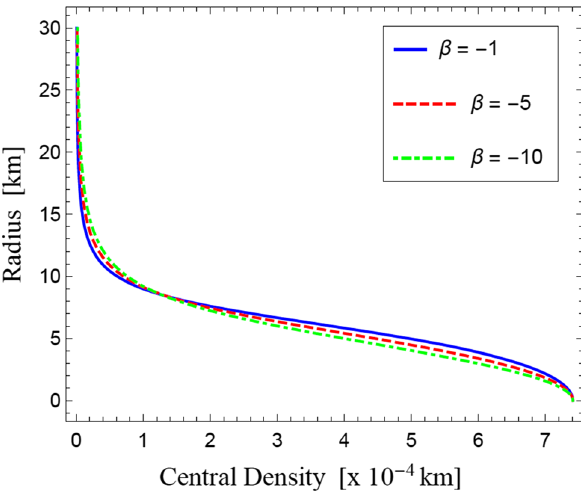
Fig. 2 Radius–central density graph of a neutron star where α = − 1 and three different variations of β . The value of (cid:19) = 4 / 3, (cid:17) = 2 [27] and ϕ = 2 . 036 × 10 − 35